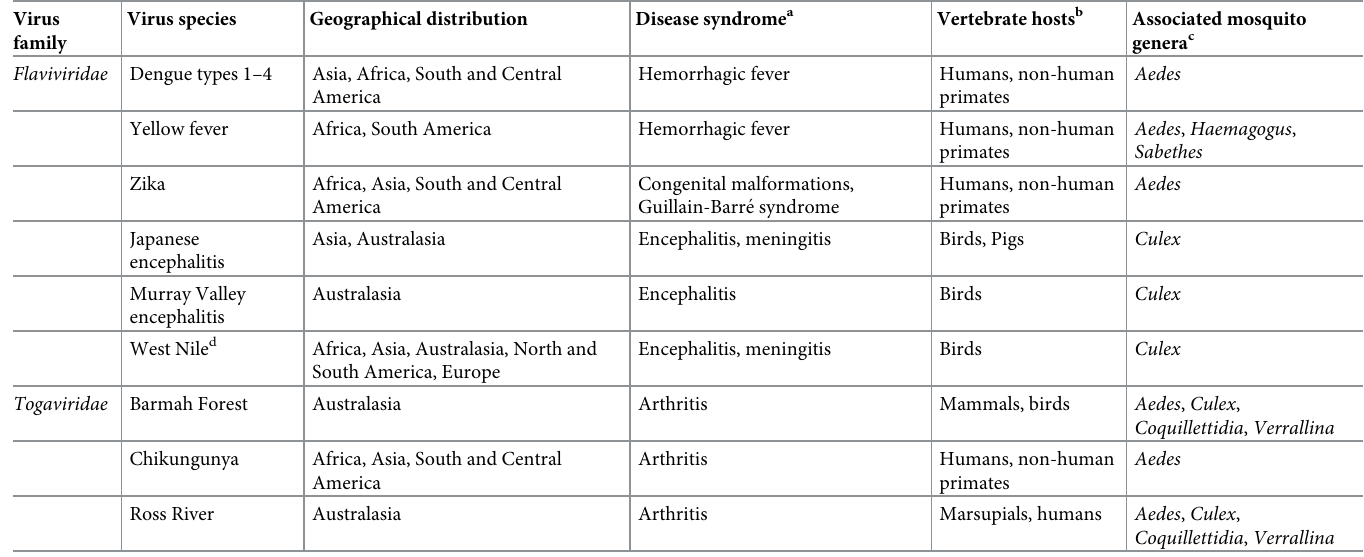
Table 1. Arboviruses assessed in vector competence experiments involving Australian mosquito species and included in the